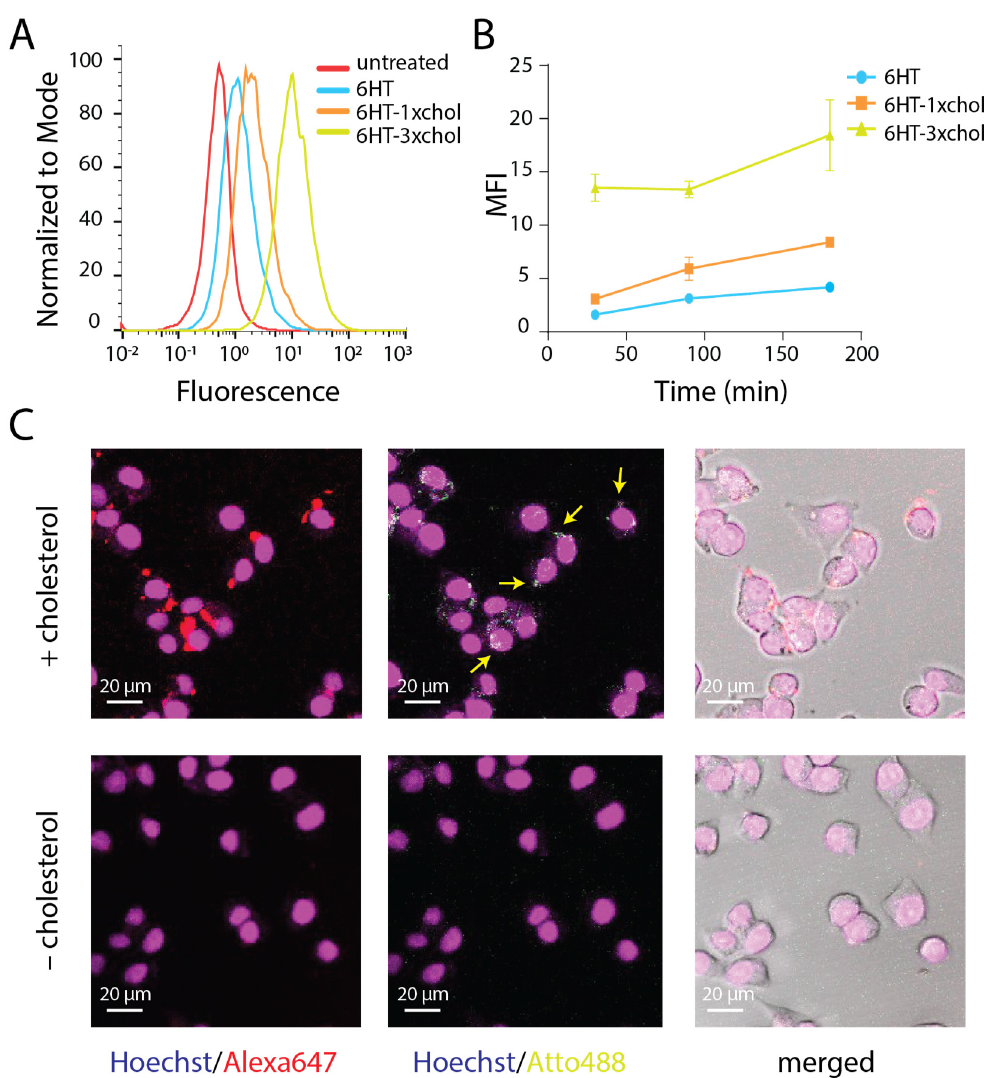
Figure 3. Interaction of DNA nanotubes with HeLa cells. ( A ) FACS analysis of cells treated for 30 min with Alexa Fluor 647-labelled DNA nanotubes. ( B ) Time-dependent binding of DNA nanotubes with varying numbers of cholesterol with HeLa cell membranes. ( C ) Confocal imaging of cells treated with DNA nanotubes labelled with Alexa Fluor 647 and conjugated to Atto488- labelled cytochrome c. Scale bars: 20 µ